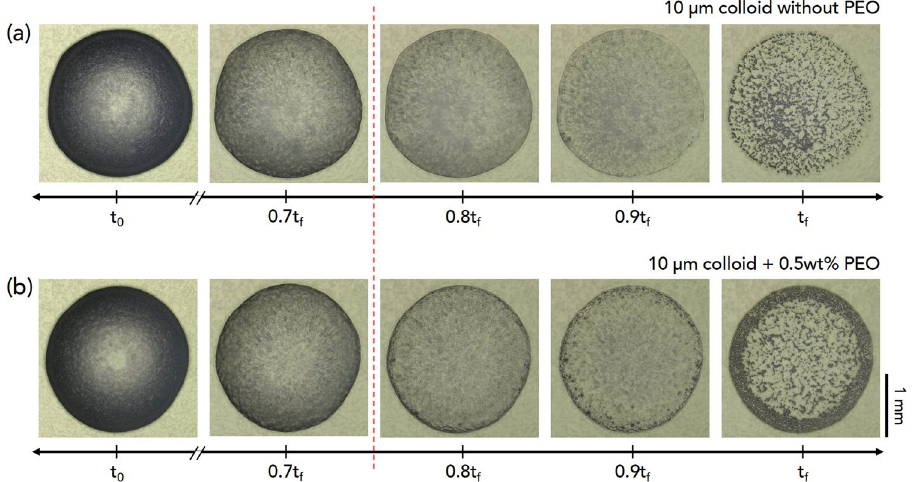
Figure 3. Evaporation evolution for large colloids. Real-time observations for evaporation evolution of large (10- μ m-diameter) colloids ( a ) without polymers and ( b ) with polymers. The evaporation time t is normalized by the complete drying time t f . Evaporation behaviors look similar before 0.8 t f but become significantly different after 0.8 t f : large colloids tend to stay randomly inside the droplet, leaving the bump-like pattern at t f of ( a ), while they move toward the perimeter, leaving the ring-like pattern at t f of ( b